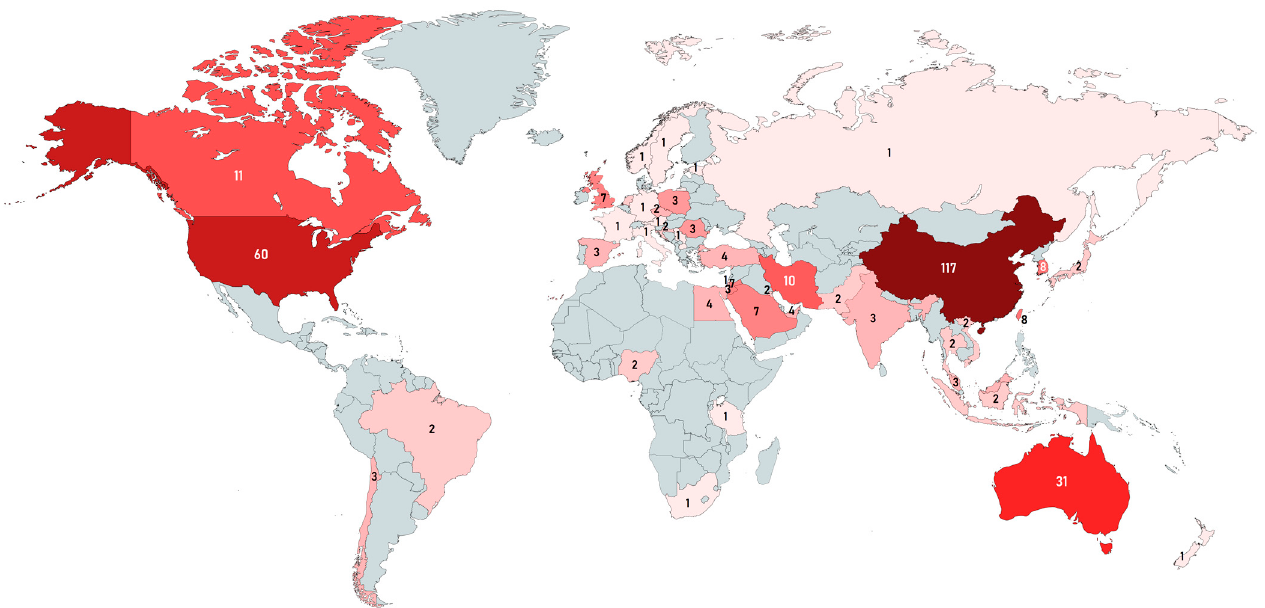
Figure 6. Contribution of countries based on the number of related publications on construction bidding research (1975–2022).